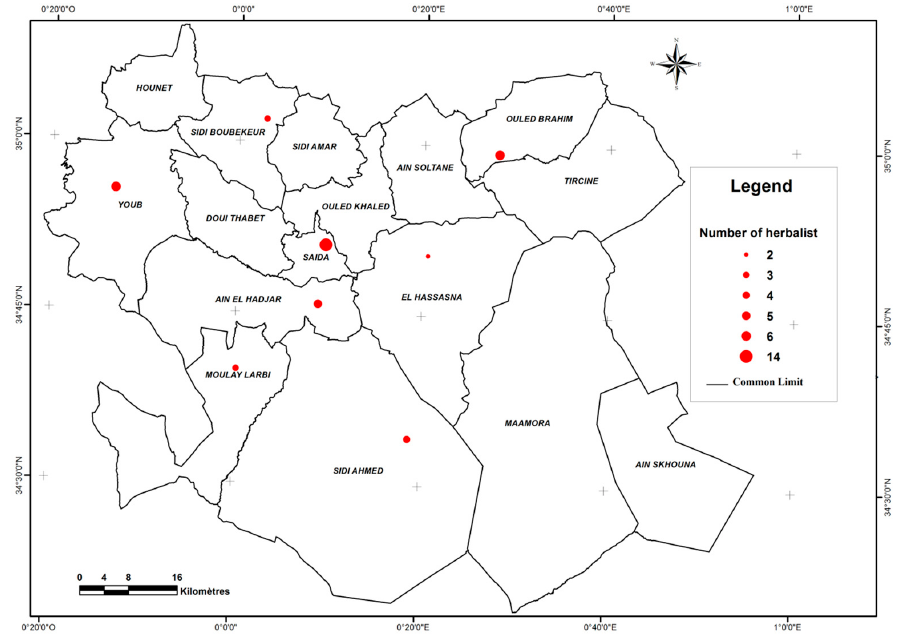
Figure 8. Distribution of survey points in the Saïda Province.